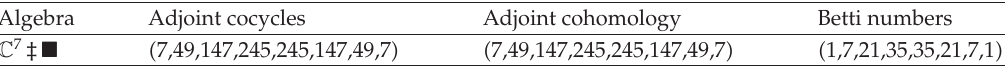
Table 10: Cohomology table for NLAs of dimension 7: rank 7 (cid:2) Abelian (cid:3)